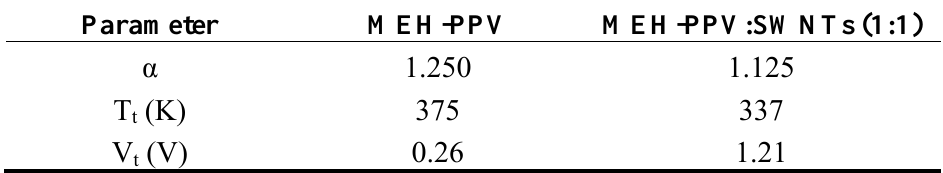
1. Extracted parameters for the dark SCLC regime of MEH-PPV and MEH-PPV:SWNTs (1:1)